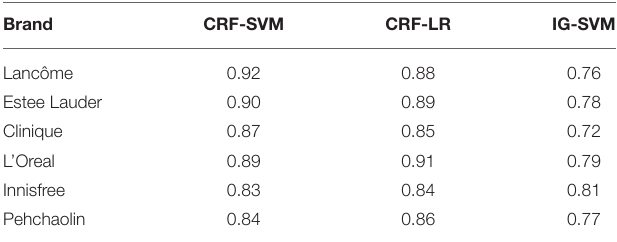
TABLE 7 | The accuracy comparison of the data from different